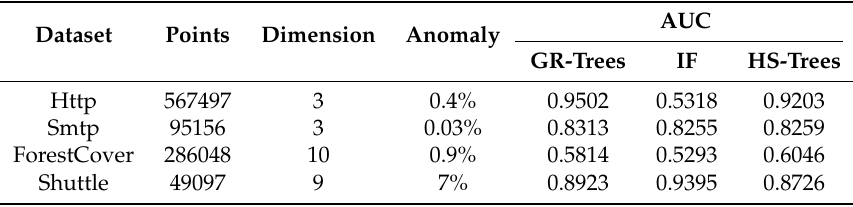
Table 1. AUC scores for GR-Trees, Isolation Forest (IF), and Streaming Half-Space-Trees